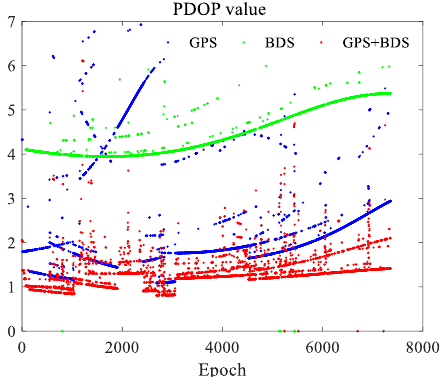
Figure 3 . Number of visible satellites (up) and PDOP